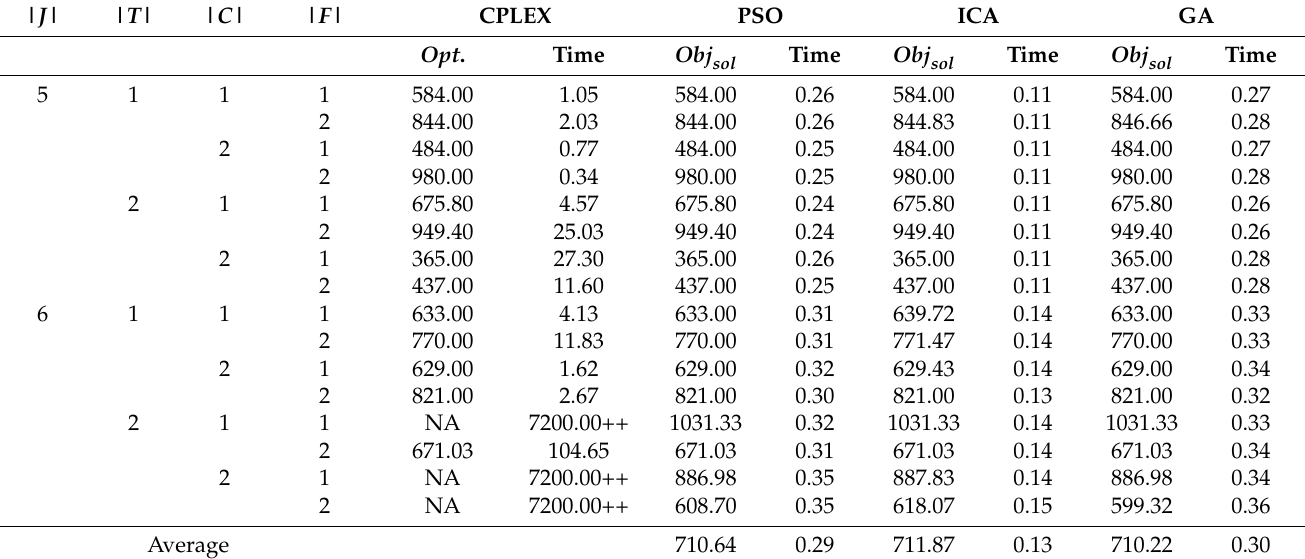
Table 6. Computational results for small problem instances ( τ =